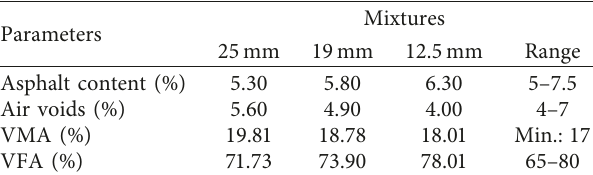
Table 1: Mix volumetric analysis of SMA mixtures.